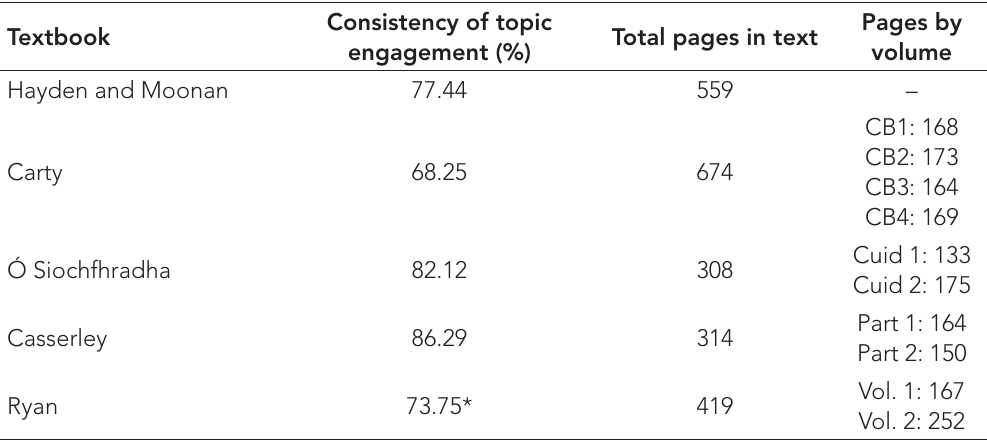
Table 1: Degree of consistency in topic engagement across all textbooks Textbook